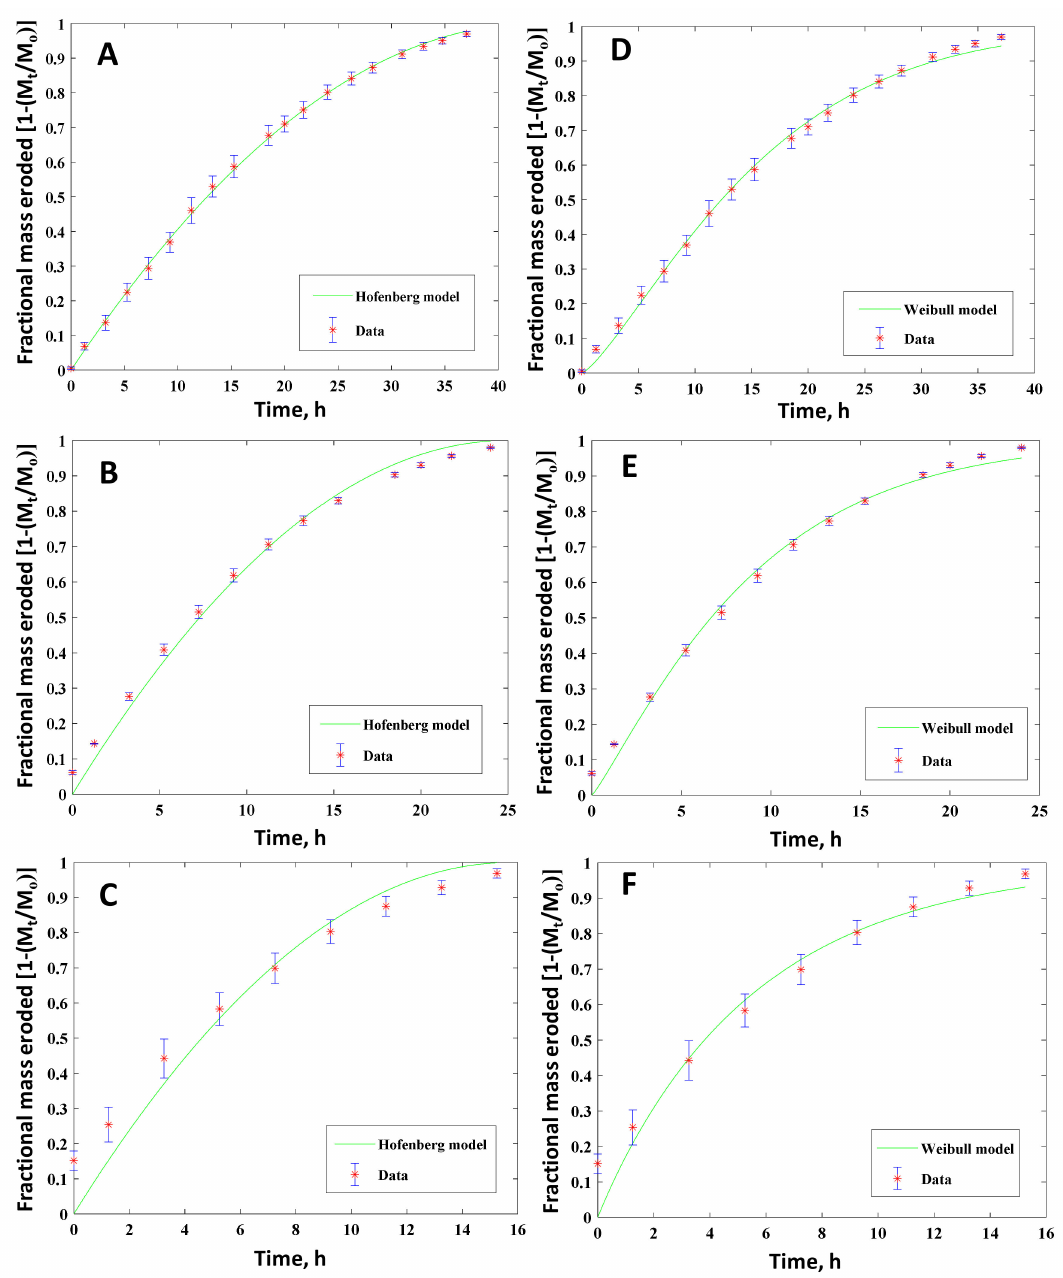
Figure 9. Fractional mass eroded as a function of time for cylindrical PAH tablets with di ff erent crosslinking ratios in PNA:PETMP:EGDT systems. Mole ratios of 100:100:0 ( A,D ), 100:75:25 ( B,E ) and 100:50:50 ( C,F ). Best fitted kinetic models with red dots (experimental data) and green lines are the fitted curves for Hopfenberg ( A–C ) and Weibull ( D–F ) release kinetic